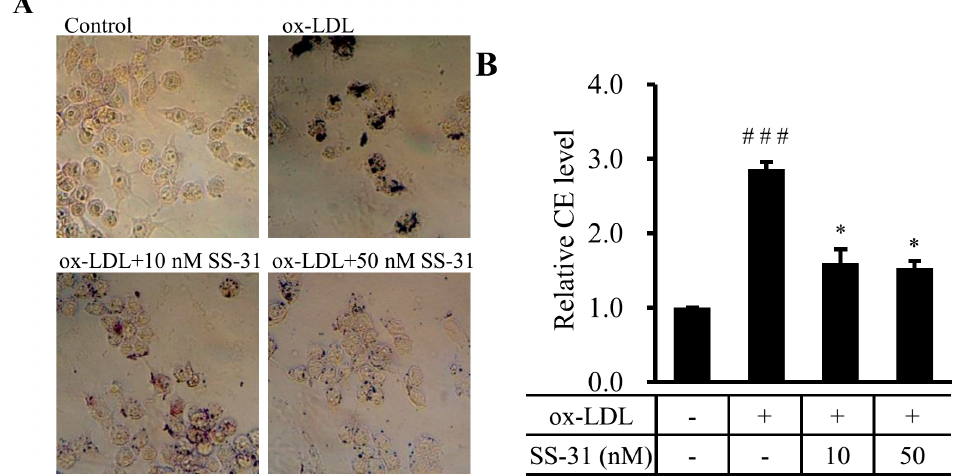
Figure 1. SS-31 reduces ox-LDL-induced lipid accumulation in RAW264.7 cells. ( A ) RAW264.7 cells were exposed to ox-LDL (50 μ g/mL) in the presence or absence of SS-31 (10 or 50 nM) for 24 h. Representative photographs showing RAW264.7 cells stained with oil red O. The dark color indicates the stained lipids and/or lipoproteins; ( B ) Levels of CE in RAW264.7 cells. Values represent mean ± SD. Treatment of the cells is the same as in ( A ). Measurement of CE is described in the Experimental Section. Results are quantitative data from four independent experiments. ### p < 0.001 compared with the control group, * p < 0.05 compared with the ox-LDL group. CE: cholesteryl ester.